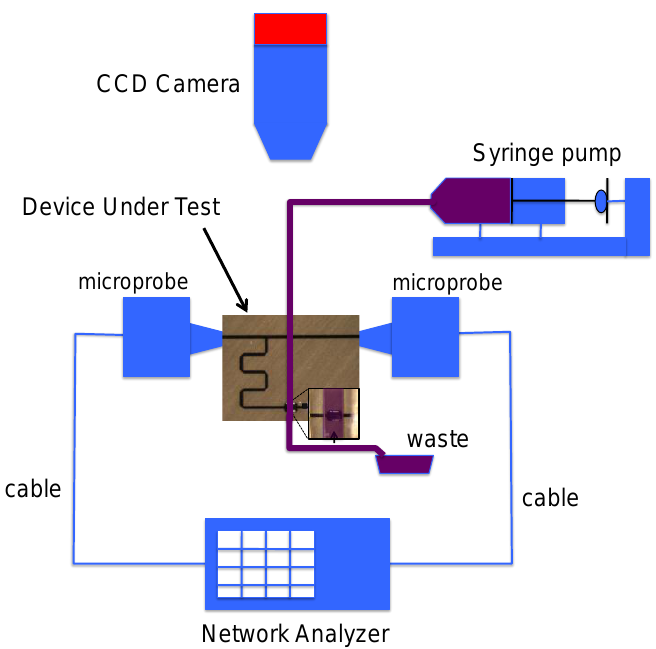
Figure 4. Block diagram of the RadioFrequency (RF) measurement setup.